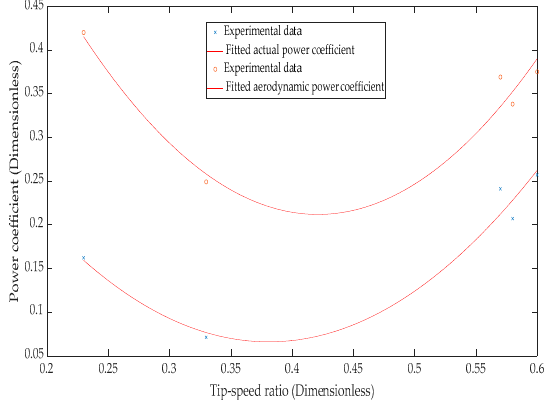
Figure 12. Power coefficient as a function of the tip-speed ratio.